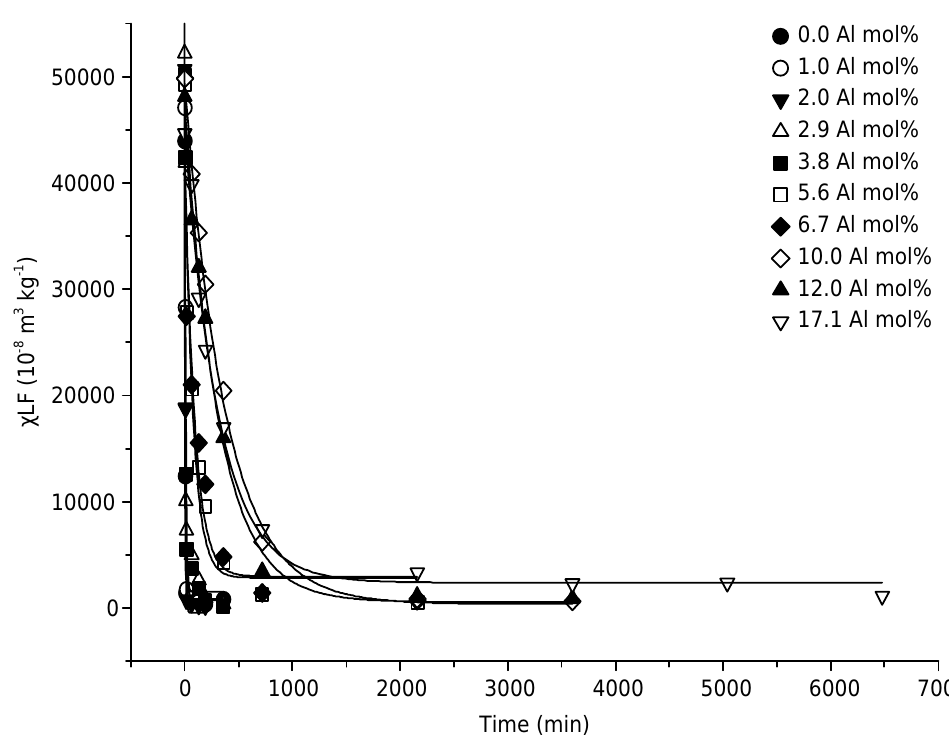
Figure 5. Mass specific magnetic susceptibility (χ LF ) values to synthetic Al-substituted maghemites submitted to different heating times at 500